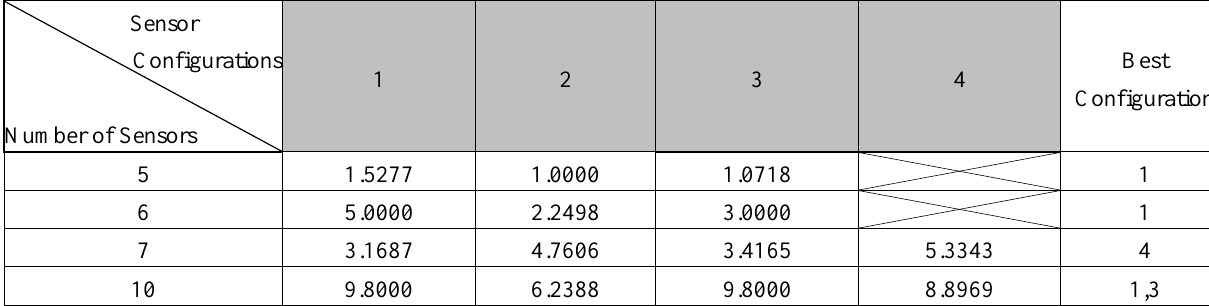
Table 12 . FDI figures of merit for configurations in Tables 3 through